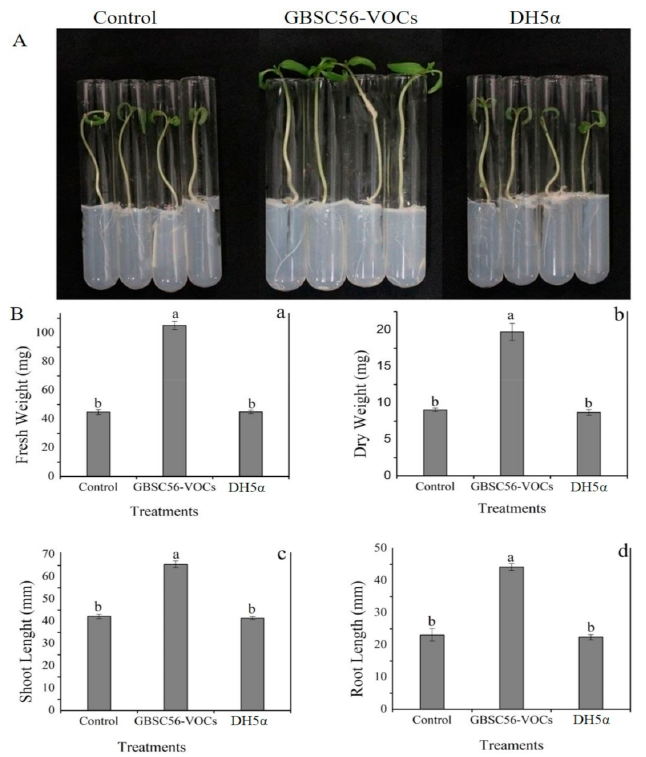
Figure 2. Seeds of tomato after surface sterilization were placed per each test tube and the resulting seedlings were grown in the presence of 20 µ l of GBSC56 culture (10 7 CFU/mL) in an airtight jar incubated at 25 ◦ C for 12 days. The effect of GBSC56-VOCs on seedlings was observed visually ( A ) and calculated by the difference ( B ) in ( a ) fresh weight, ( b ) dry weight, ( c ) shoot length, and ( d ) root length after exposure to GBSC56-VOCs. Error bar represents the mean standard deviation of each treatment. The small letters above the columns indicate significant difference. The significant difference among the treatments was calculated through the Tukey HSD test at p ≤